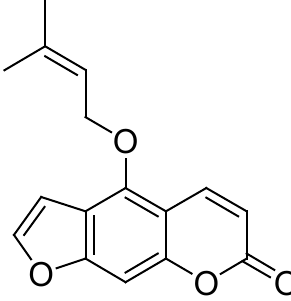
Figure 1. Chemical structure of